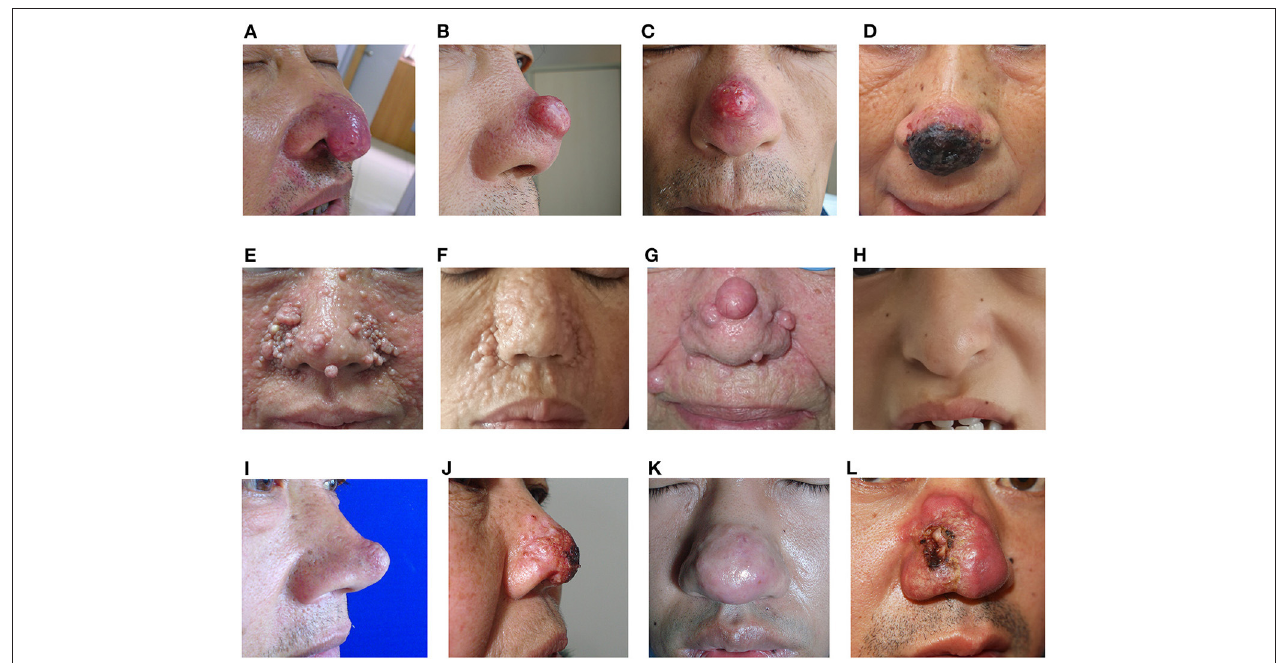
FIGURE 1 | Clinical images of clown nose-like lesions. (A–D) Clown nose-like lesions secondary to metastatic visceral tumors. (A) A 65-year-old man with lung squamous cell carcinoma (case 4 in Table 1 ), initially misdiagnosed as rosacea; (B,C) a 65-year-old man with lung squamous cell carcinoma (case 2 in Table 1 ), initially misdiagnosed as folliculitis; (D) a 63-year-old woman with lung squamous cell carcinoma (case 1 in Table 1 ), initially misdiagnosed as basal cell carcinoma. (E–H) Clown nose-like lesions nose as manifestations of genetic syndromes. (E) A 34-year-old woman with tuberous sclerosis (case 6 in Table 3 ); (F) a 40-year-old woman with multiple familial trichoepithelioma (case 5 in Table 3 ); (G) a 85-year-old woman with Brooke-Spiegler syndrome (11); (H) a 13-year-old girl with Tricho-Rhino-Phalangeal Syndrome in our department. (I–L) Primary skin disease of clown nose-like lesions. (I) A 47-year-old man with sebaceous gland hyperplasia (case 12 in Table 4 ); (J) a 62-year-old woman with superficial skin mycosis (case 8 in Table 4 ); (K) a 42-year-old man with rosacea (case 10 in Table 4 ); (L) a 34-year-old man with nasal squamous cell carcinoma (case 9 in Table 4 ).